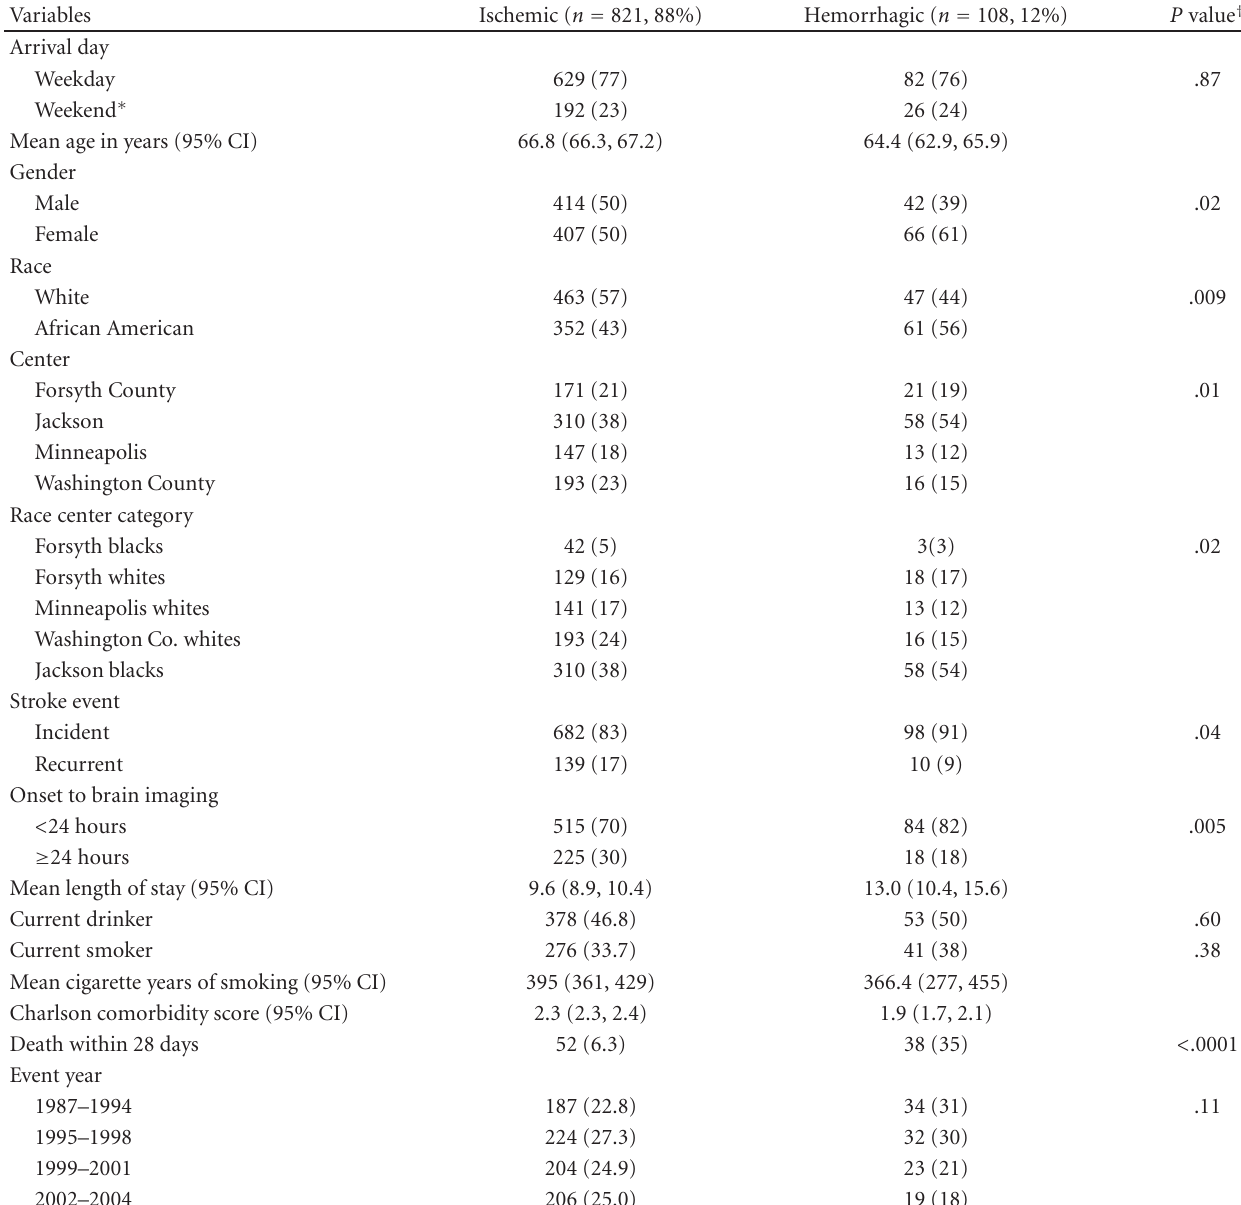
Table 4: Baseline characteristics (1987–1989) of stroke patients by stroke type in the atherosclerosis risk in communities (ARIC)